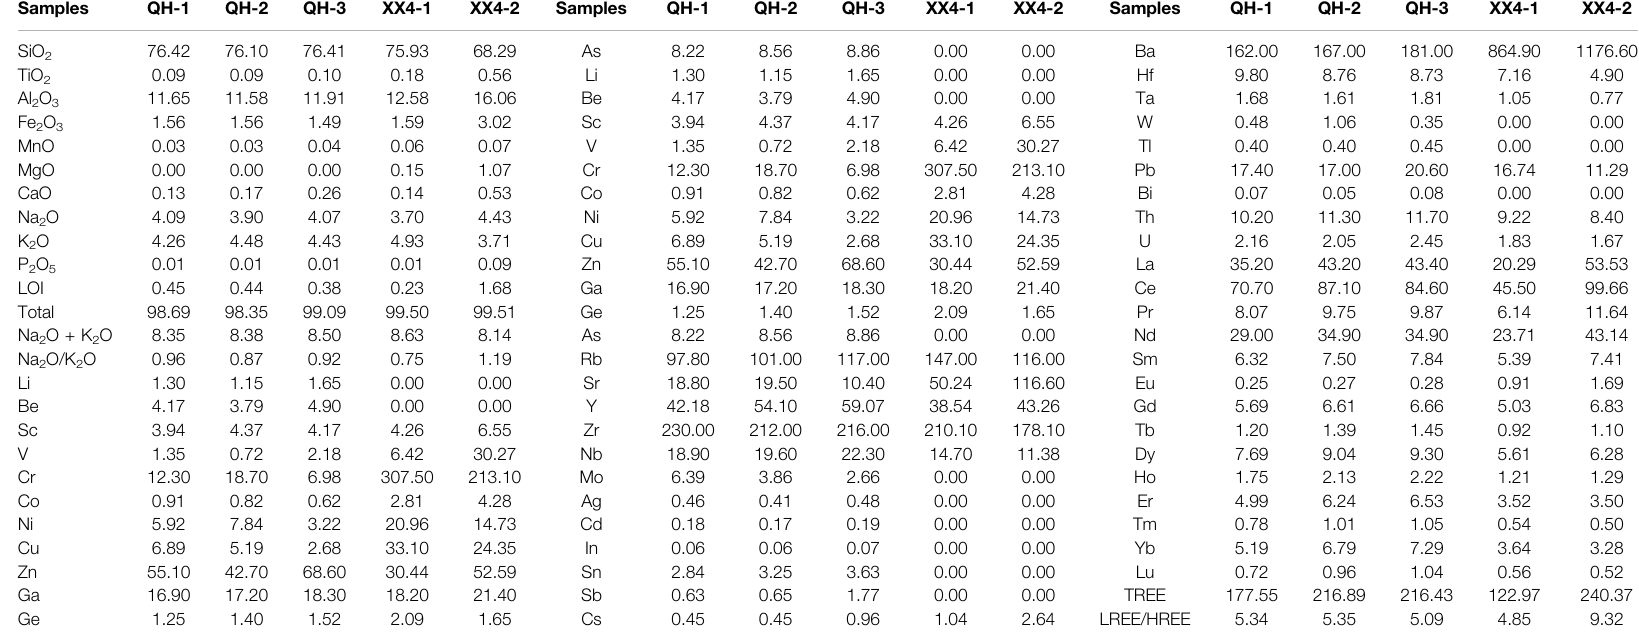
TABLE 1 | Analytical results of major (%) and trace elements ( μ g/g) for the Xinxian paragneisses. Samples